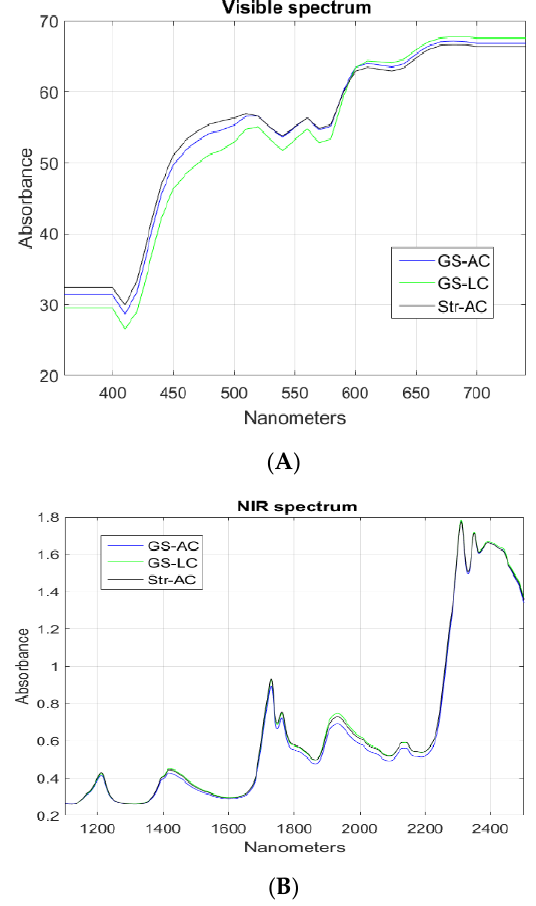
Figure 2. ( A , B ). Average VIS and NIR spectra. GS-AC = ad libitum grass silage plus ad libitum concentrate diet; GS-LC = ad libitum grass silage plus limited concentrate diet; Str-AC = barley straw plus ad libitum concentrate diet.